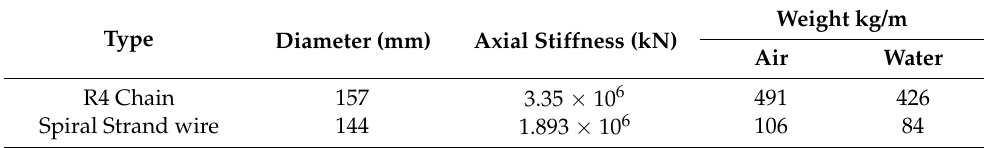
Table 1. Properties of the mooring